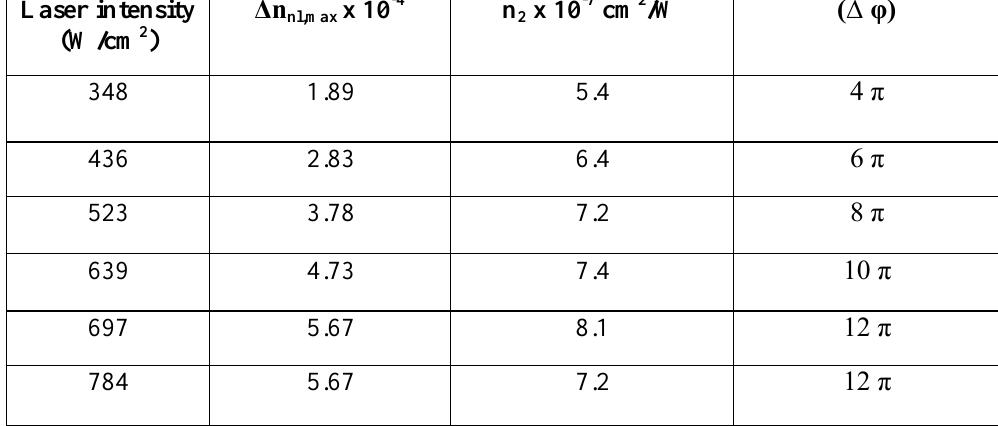
Table 2: The values of the maximum change of nonlinear refractive index, the related nonlinear refractive index values and the phase shift for silver nano-fluid sample with the mean particle size of 50